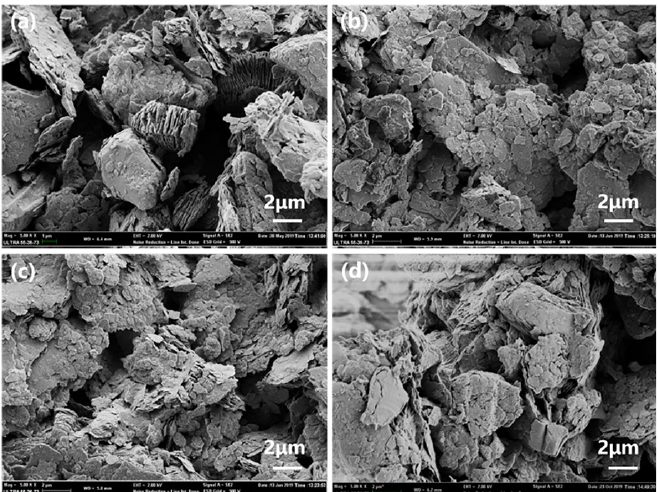
Figure 2. SEM images of various modified MMT: ( a ) MMT (5000×); ( b ) HCl-MMT (5000×); ( c ) SDS-MMT (5000×); ( d ) CTS-MMT (5000×).